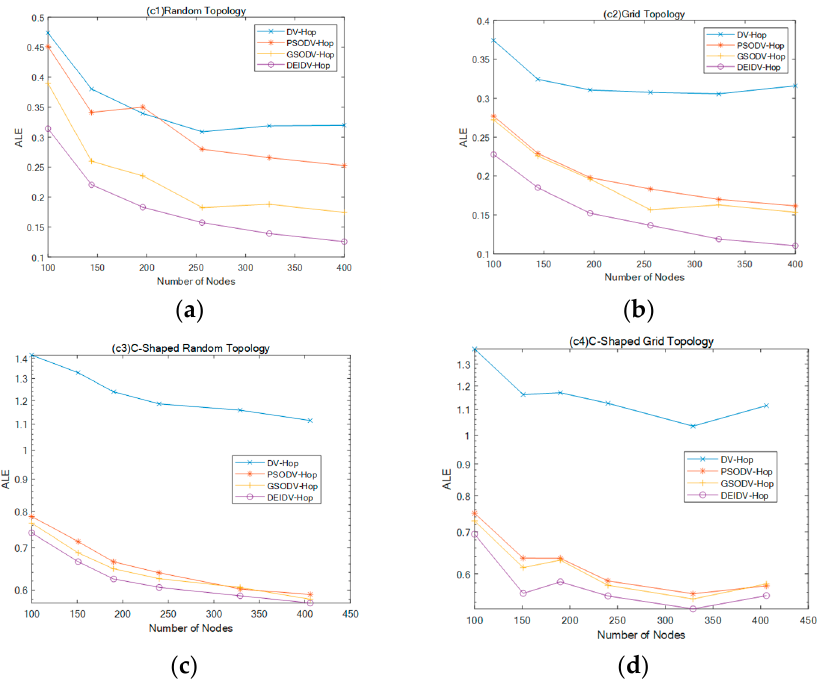
Figure 8. ( a ) Effect of the total number of nodes on ALE in square random topology; ( b ) Effect of the total number of nodes on ALE in a square grid topology; ( c ) Effect of the total number of nodes on ALE in C-Shaped random topology; ( d ) Effect of the total number of nodes on ALE in C-Shaped grid topology.